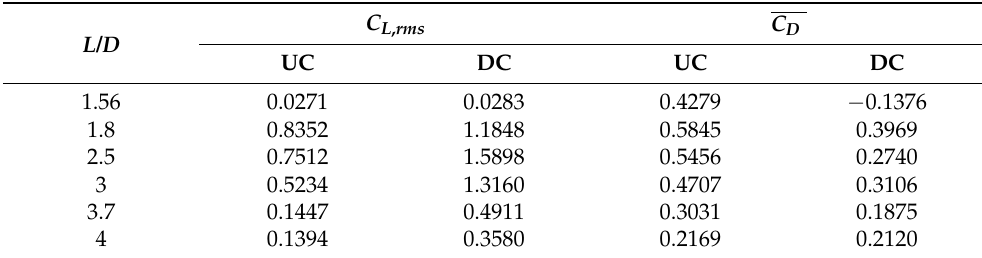
Table 3. The values of C L , rms and C D for different distance ratios. C L , rms C L / D